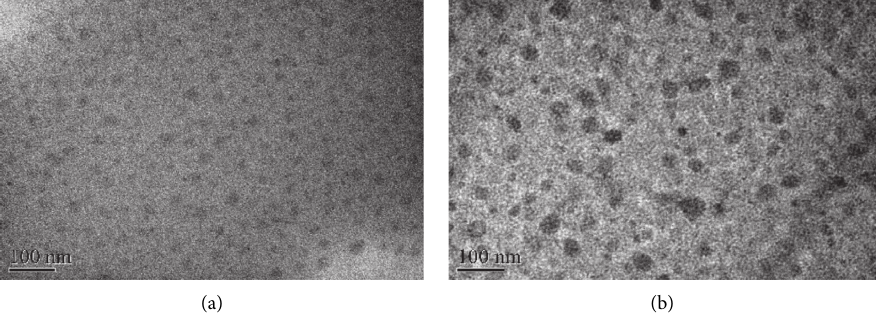
Figure 4: Typical TEM images of P4 (a) and P4 ′ (b).